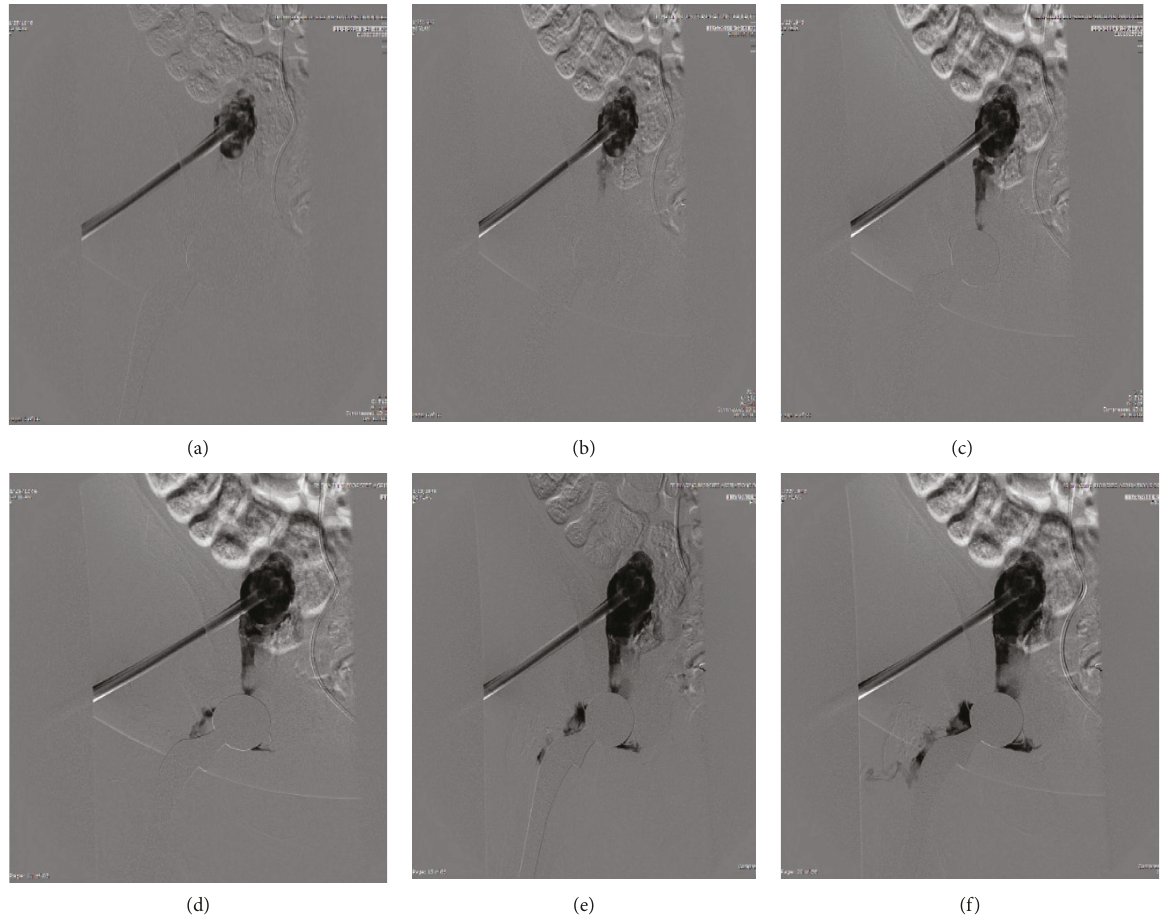
Figure 6: Flow of contrast dye tracking along the iliopsoas bursa into the hip joint.